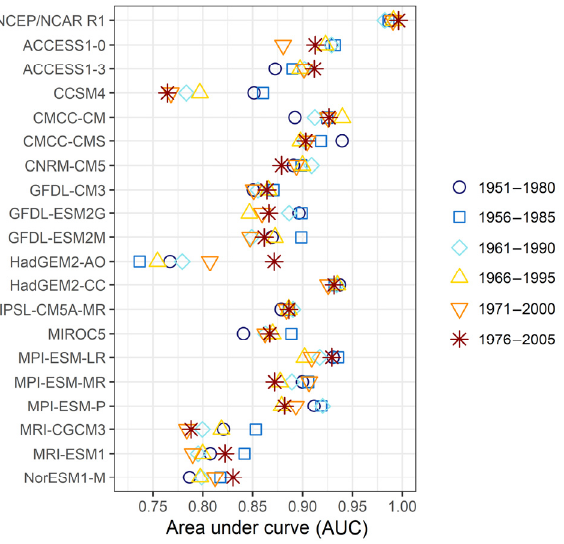
Figure 4. Area under curve (AUC) values corresponding to the ROC curves in Figure 3. Results of the GCMs are presented in alphabetical order.